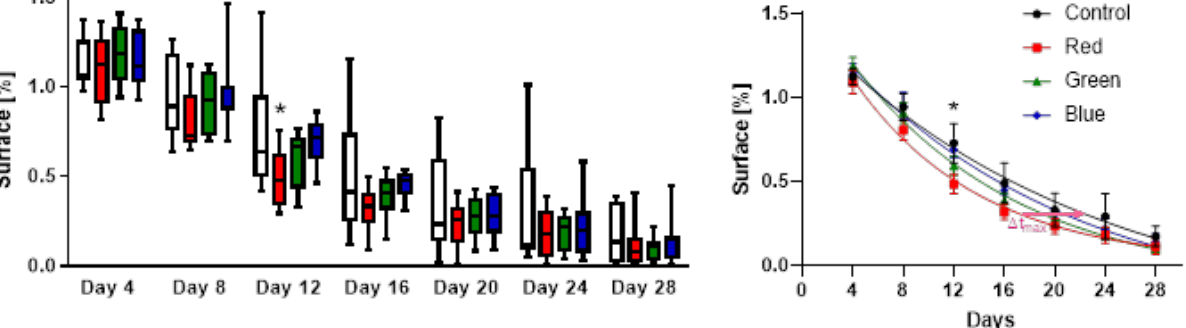
Figure 3. Effects of pulsing LED photobiomodulation therapy of different wavelengths on wound size in percentage changes of wound area relative to day 0 in an excision wound model in diabetic (db/db) mice. The plot on the left shows the median and distribution and the plot on the right shows the mean ± SEM including exponential decay regression fits. Wounds were excised and treated with PBM for 6 min every other day for 28 days. Starting from day 8 after surgery, red and green light showed reduced wound area compared to the control with a maximum delay of 5.1 days over the red group past day 16. n = 8, * p < 0.05 compared to the not illuminated control group.